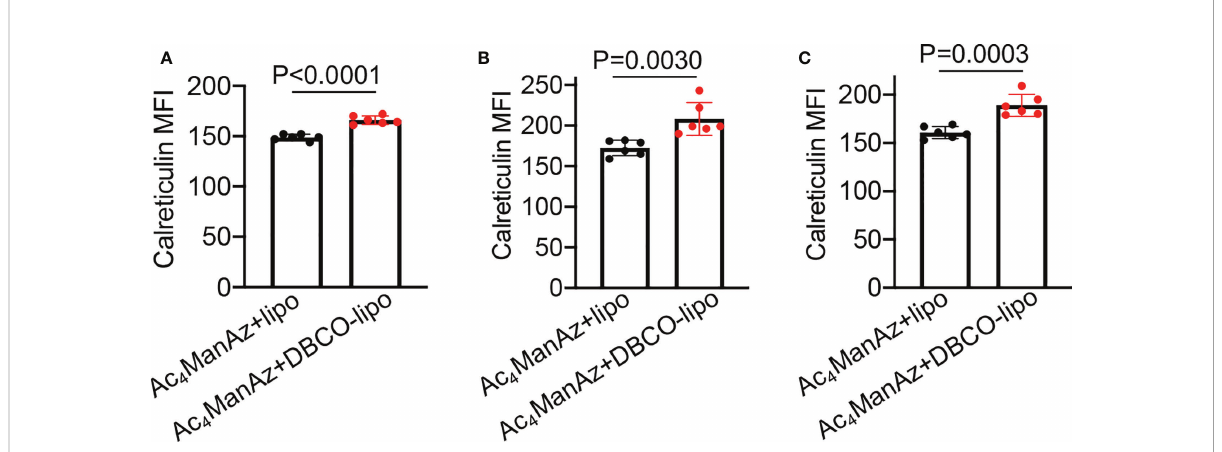
FIGURE 4 In vitro targeting of DBCO-liposomes to azido-labeled 4T1 cancer cells improves immunogenic cell death. 4T1 cells were pretreated with Ac for 48 h, followed by incubation with DBCO-modi fi ed or DBCO-unmodi fi ed, Dox-loaded liposomes at different Dox concentrations for 16 h. Shown are the mean calreticulin fl uorescence intensity of 4T1 cells after treatment with liposomes at a Dox concentration of (A) 50 nM, (B) 500 nM, or (C) 5 µM. All the numerical data are presented as mean ±